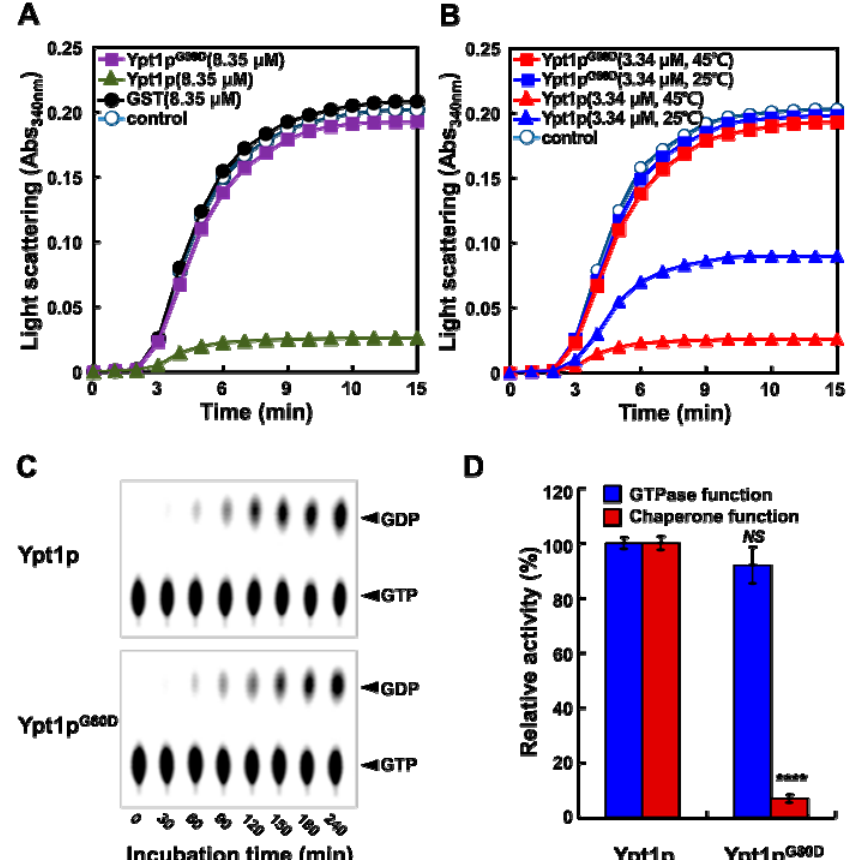
Figure 4. Ypt1p G80D has GTPase Activity but not Molecular Chaperone Activity . (A, B) Chaperone activity assay. Light scattering was monitored at 340 nm over a 15 min incubation period. Shown are representative data out of at least three independent experiments. (A) Solutions of MDH (1.67 μ M) alone ( -o- ) or with 8.35 μ M GST ( - ● - ), Ypt1p ( - ▲ - ), or Ypt1p G80D ( - ■ - ) in 50 mM HEPES (pH 8.0) were incubated in a spectrophotometer cell at 45 °C. (B) Solutions of MDH (1.67 μ M) alone ( -o- ) or with 3.34 μ M Ypt1p pretreated at 25 °C ( - ▲ - ) or 45 °C ( - ▲ - ) or 3.34 μ M Ypt1p G80D pretreated at 25 °C ( - ■ - )